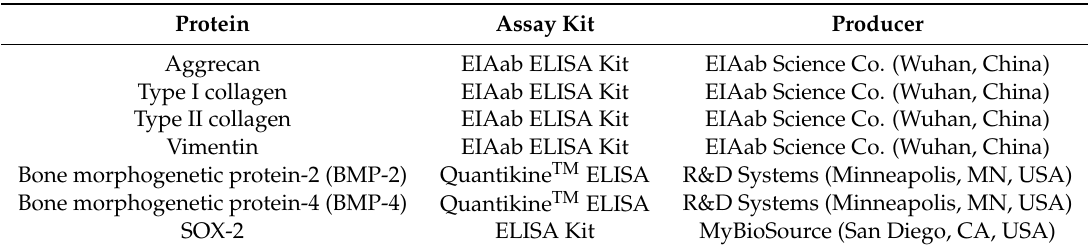
Table 4. The list of proteins measured in the conditioned media after the last day of the in vitro experiment, and commercial names and producers of assay kits.